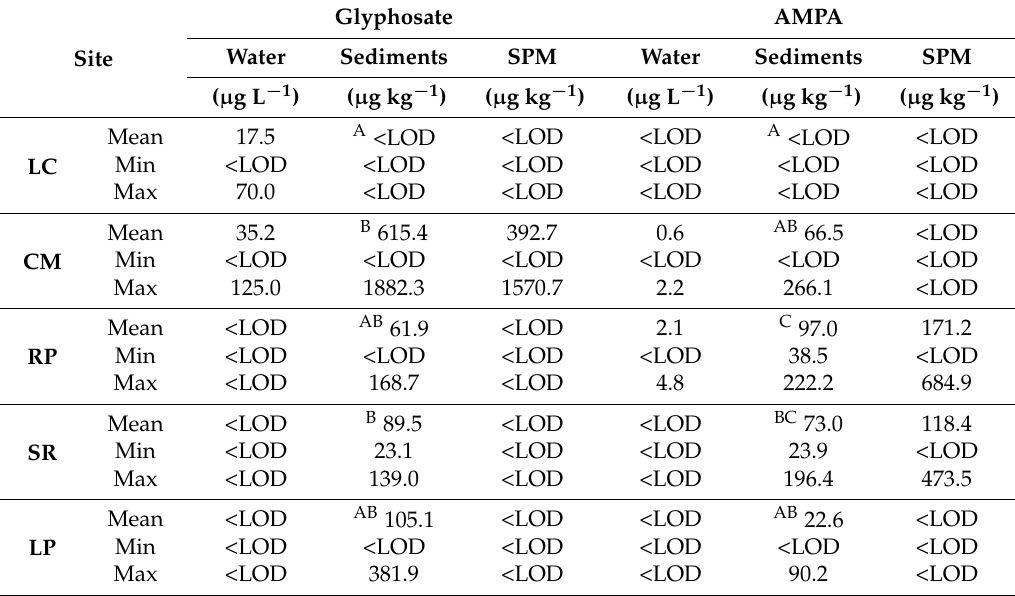
Table 3. Concentration of glyphosate and aminomethylphosphonic acid (AMPA) in water, sediment and suspended particulate matter (SPM) samples collected in Suqu í a River basin. Different letters, when indicated, represent significant differences between monitoring stations ( p <